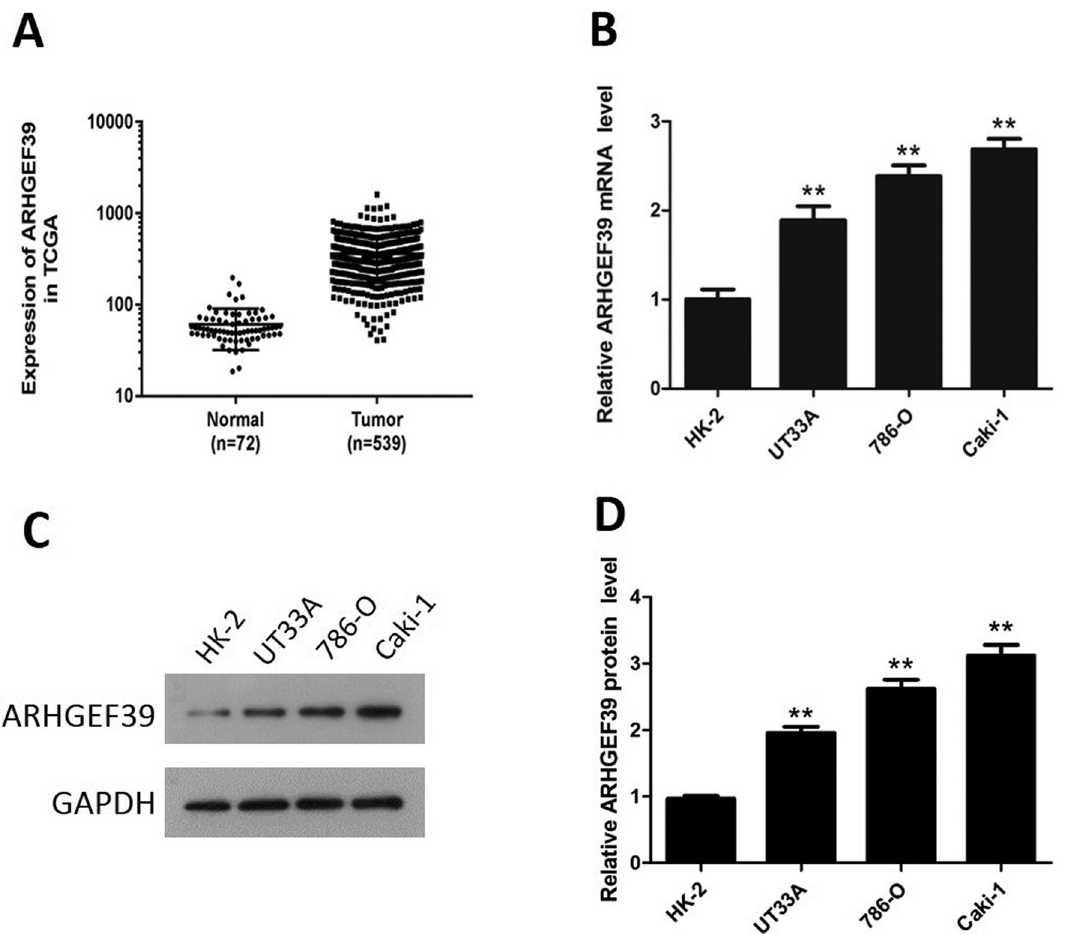
Figure 1 - ARHGEF39 expression in ccRCC. A) The expression differences of ARHGEF39 mRNA in ccRCC and normal kidney tissues in TCGA data- base (tumor n = 539, normal n = 72, p = 0.0005). B) Expression of ARHGEF39 mRNA in UT33A, 786-O, Caki-1 and HK-2 cells (qRT-PCR method). C) Expression of ARHGEF39 protein in UT33A, 786-O, Caki-1 and HK-2 cells (Western blotting method). D) The relative protein level of ARHGEF39 in UT33A, 786-O, Caki-1 and HK-2 cells. **p <